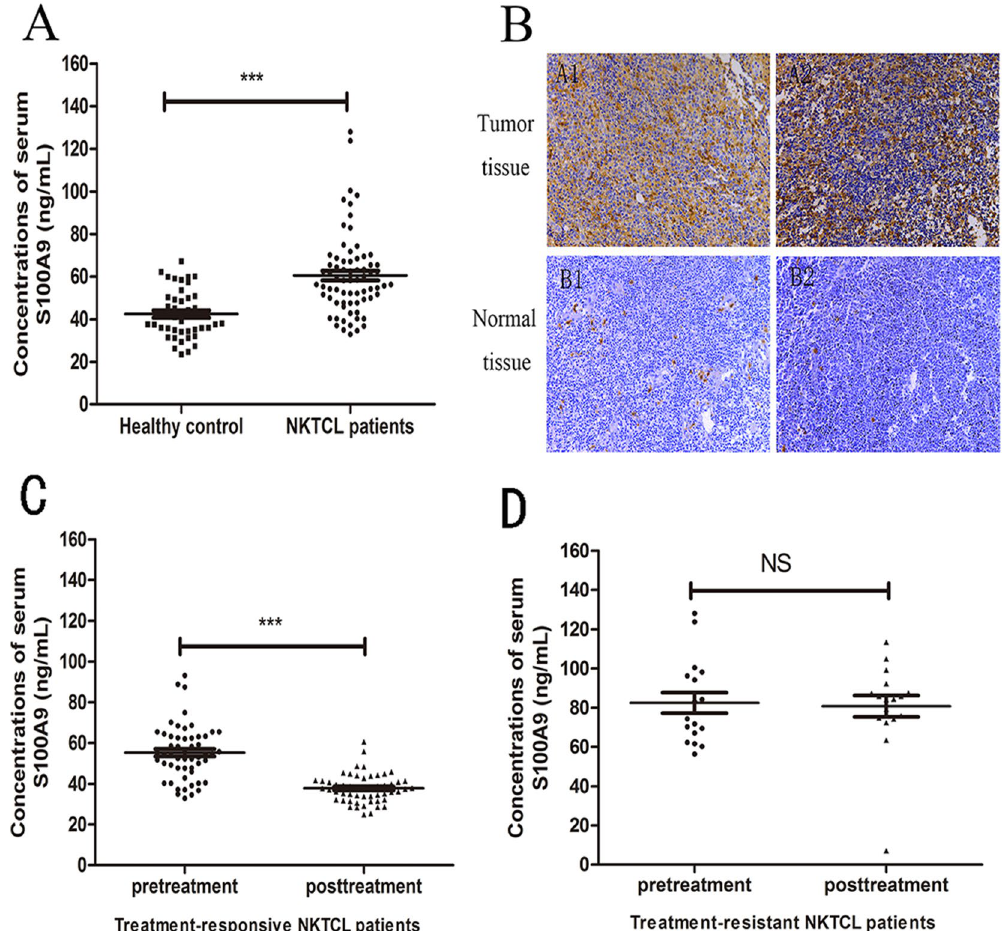
Figure 2. Validation of candidate protein S100A9 in NKTCL patients and healthy individuals. ( A ) NKTCL patients displayed higher serum levels of S100A9 than healthy individuals ( p < 0.001). ( B ) Normal nasal tissues did not express S100A9 protein, while S100A9 was highly expressed by tumor stromal cells in NKTCL tumor tissues. ( C ) Posttreatment levels of S100A9 declined dramatically compared with pretreatment levels in chemo- sensitive patients ( p < 0.001). ( D ) No significant change was observed between pretreatment and posttreatment levels of S100A9 ( p > 0.05). *** p < 0.001, ** p < 0.01, NS p >